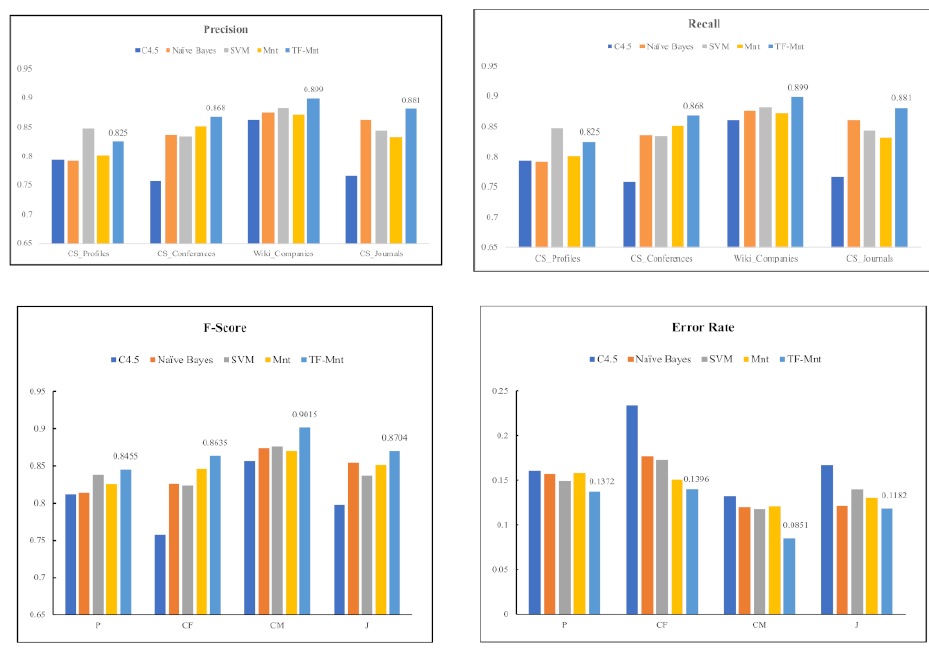
Figure 9. Comparison of performances between